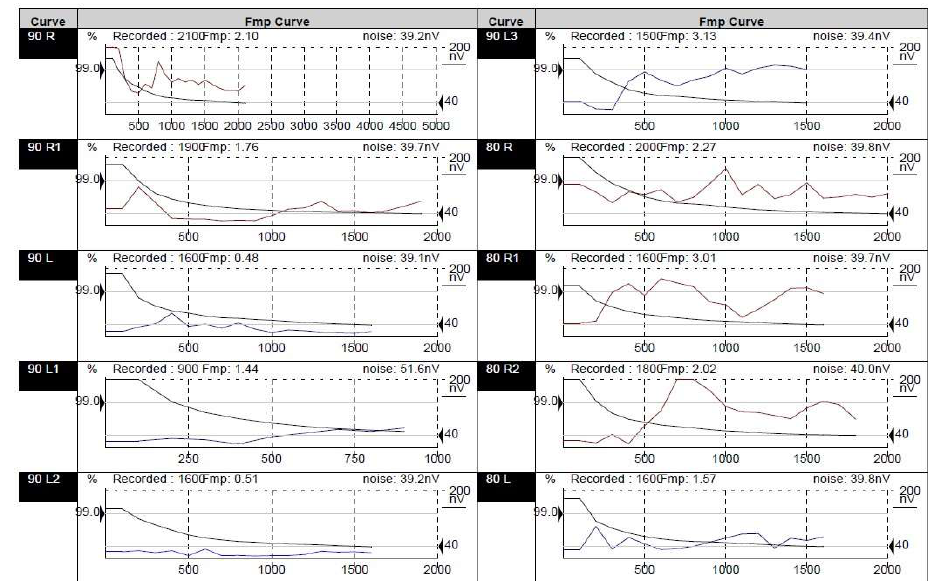
Figure 3. Auditory Evoked Potentials results for Case 1 (extended results). No evoked response until 90 dB nHL bilaterally.